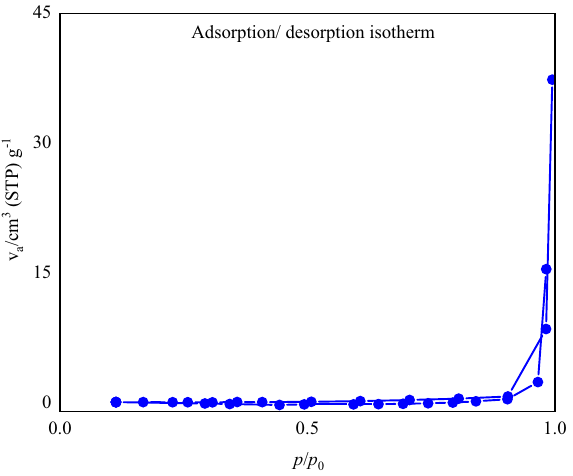
Figure 13. The nitrogen adsorption–desorption curve (BET) of the FSiPSS nano-catalyst.